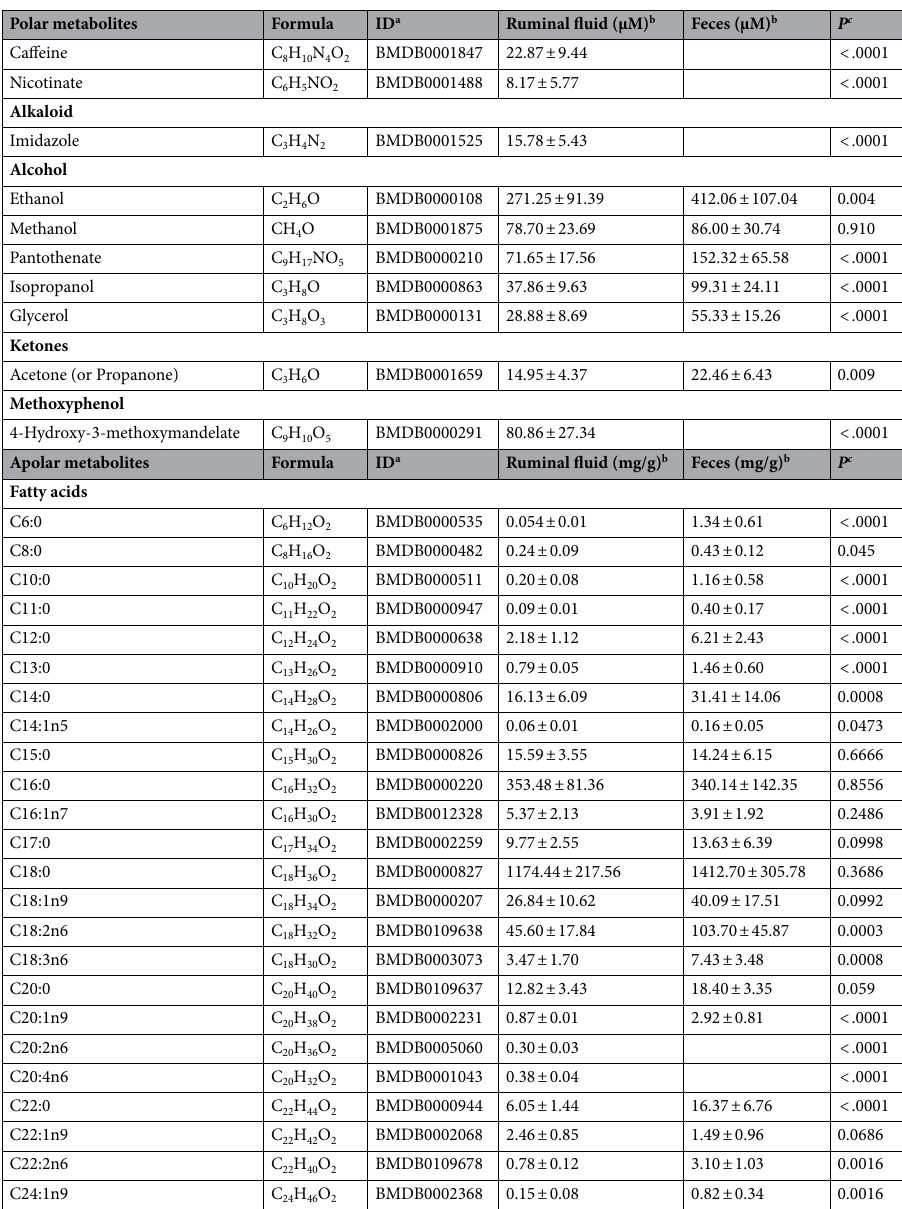
and GC-FID. a ID Bovine Metabolome Database (BMDB). b Mean ± Standard deviation. c P correspond to the original P-value calculated from the enrichment